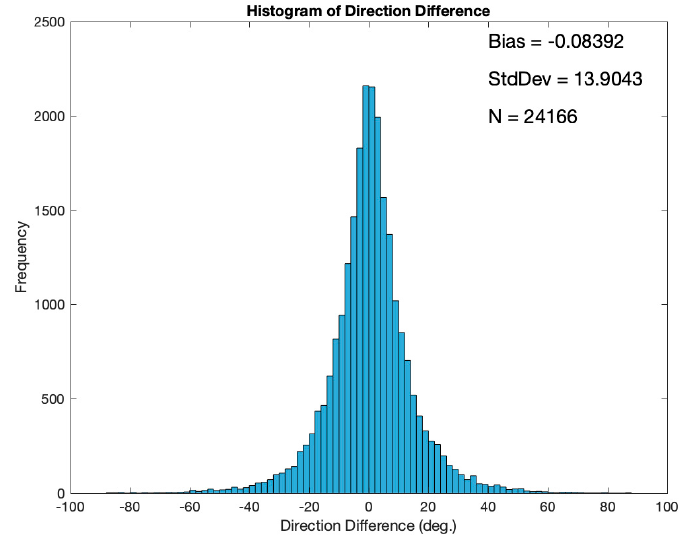
Figure 9. Histogram of the direction difference between co-located Aqua MODIS and AIRS retrieval AMVs for a northern hemisphere summer case: 14 June to 31 July 2012. Mean = − 0.08°; Standard Deviation = 13.90°.